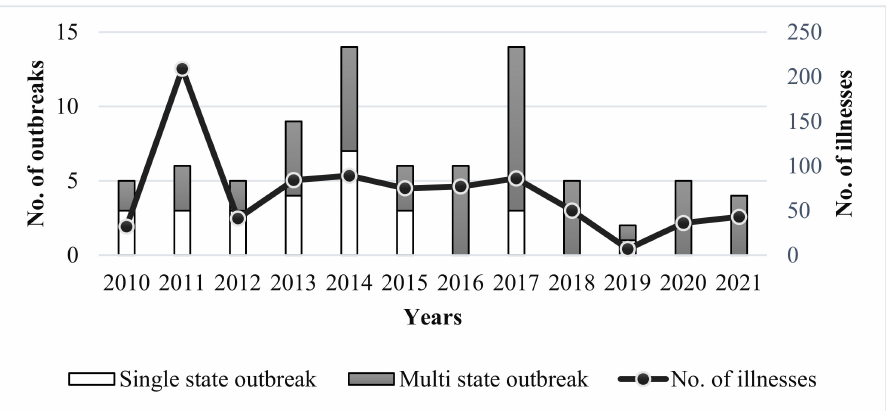
Figure 1. The reported single-state and multi-state outbreaks of listeriosis and total number of associated illnesses from 2010 to 2021, data derived from CDC’s Foodborne Disease Outbreak Surveillance System, United States